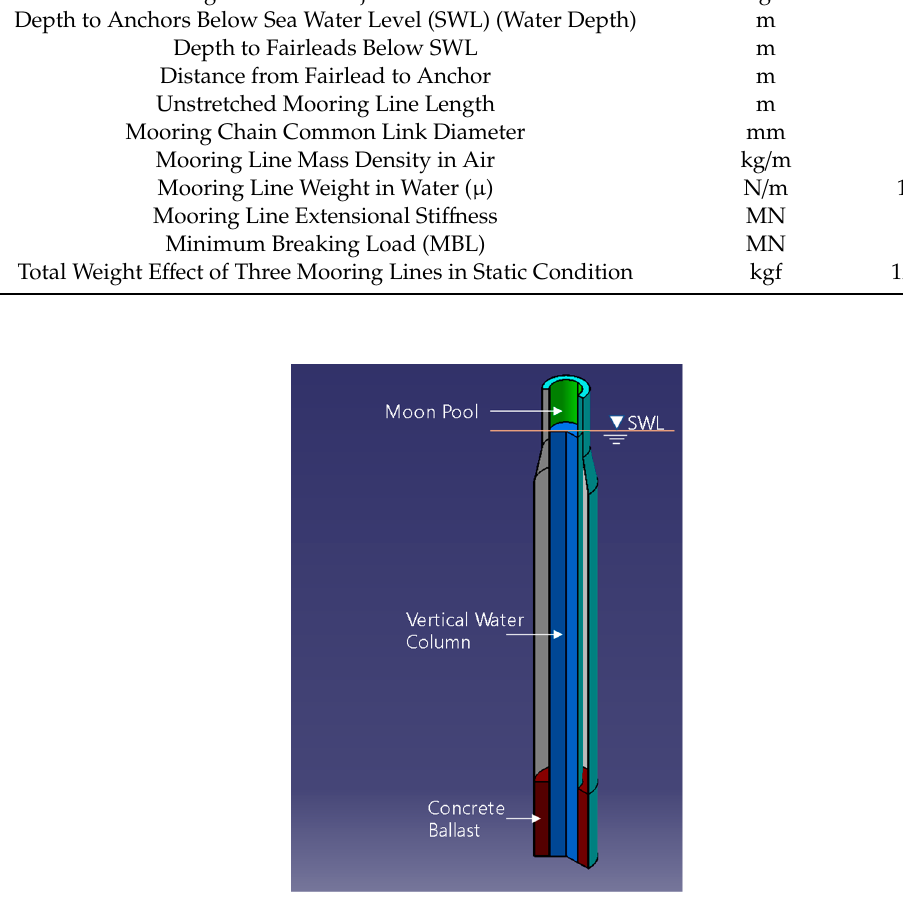
Figure 1. Concept of spar-type floating offshore wind turbine (FOWT) combined with an open moonpool. Note: SWL = sea water level.